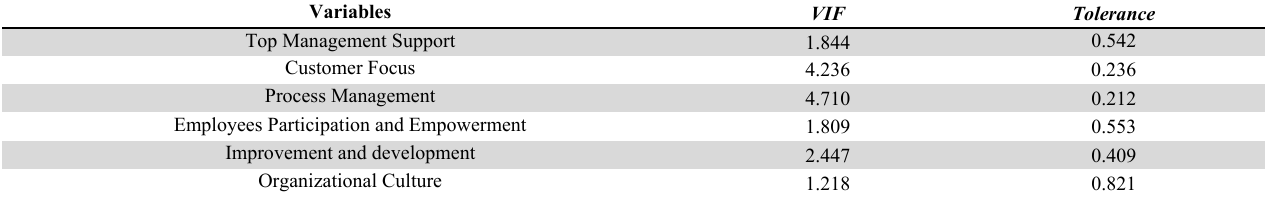
Multi-collinearity Test to independent